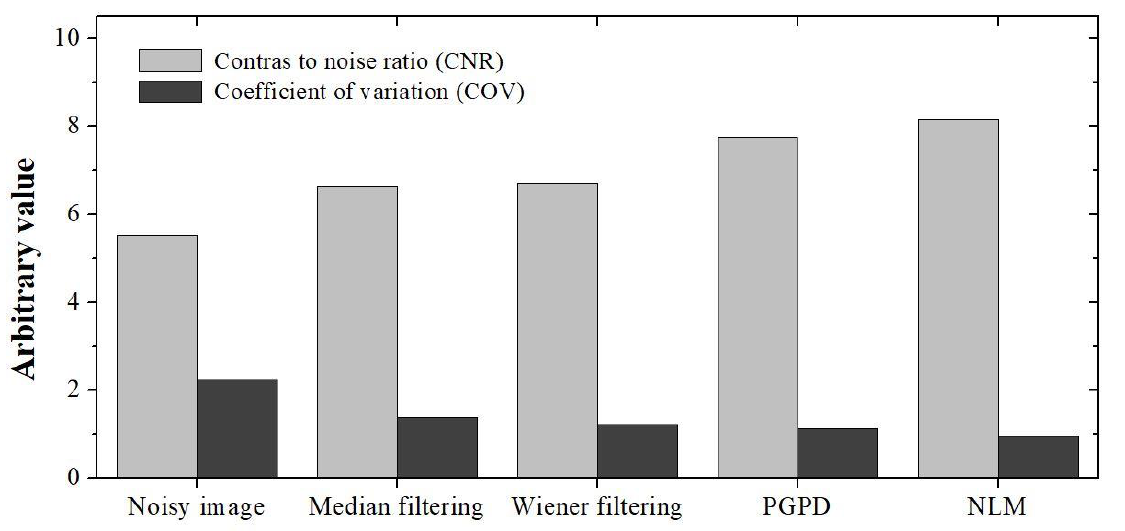
Figure 7. Graphs for quantitative evaluation of CNR and COV in acquired human thyroid ultrasound images.